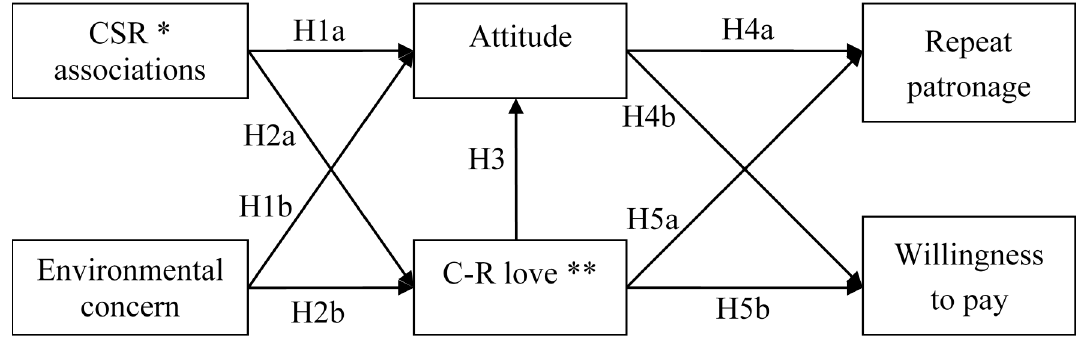
Figure 1. The theoretical model. *: corporate social responsibility. **: consumer ‐ retailer love.